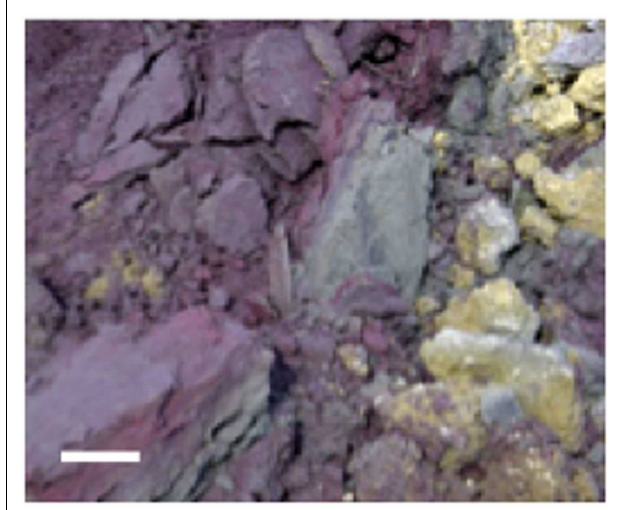
FIGURE 1 | Photograph of cinder deposits adjacent to acid pond in Stege Marsh. Purple and gray materials are primarily hematite and specular hematite, and yellowish material is mainly lepidocrocite with some elemental sulfur. Scale bar is ∼ 10cm.